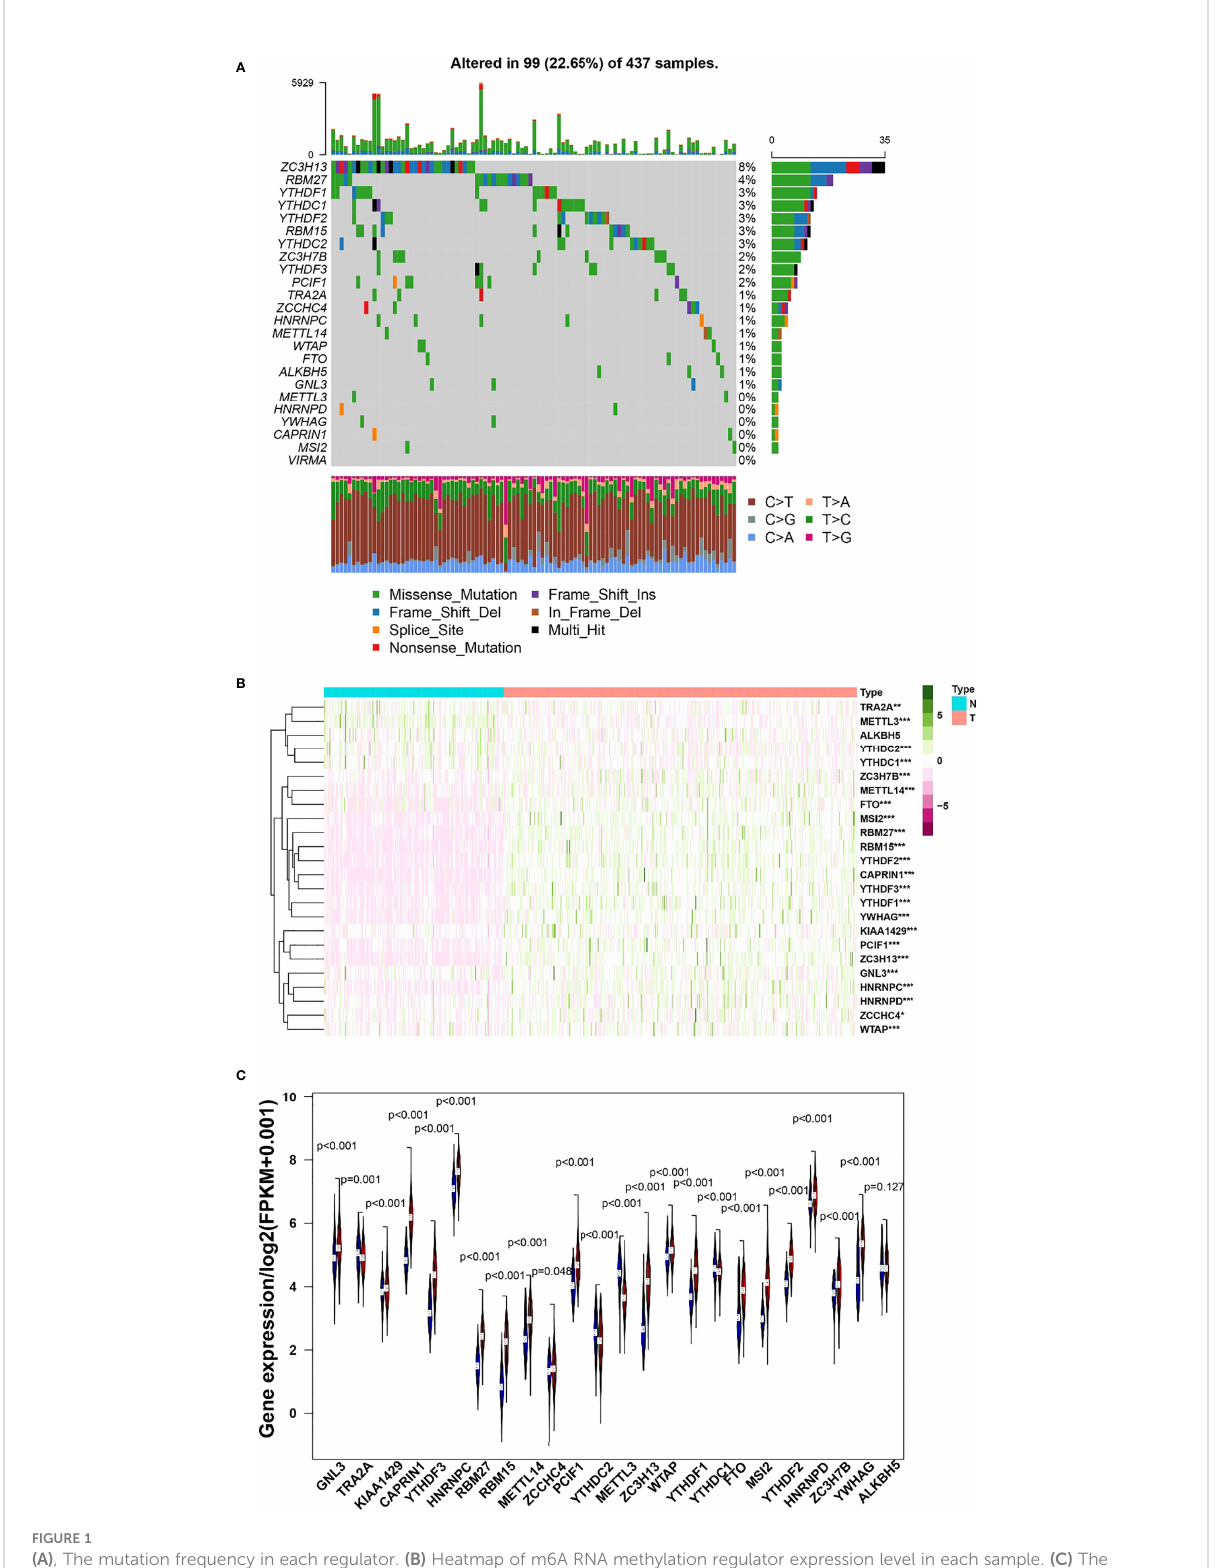
FIGURE 1 (A) , The mutation frequency in each regulator. (B) Heatmap of m6A RNA methylation regulator expression level in each sample. (C) The expression difference of m6A RNA methylation regulator between tumor and normal sample. *p<0.05; **p<0.01;